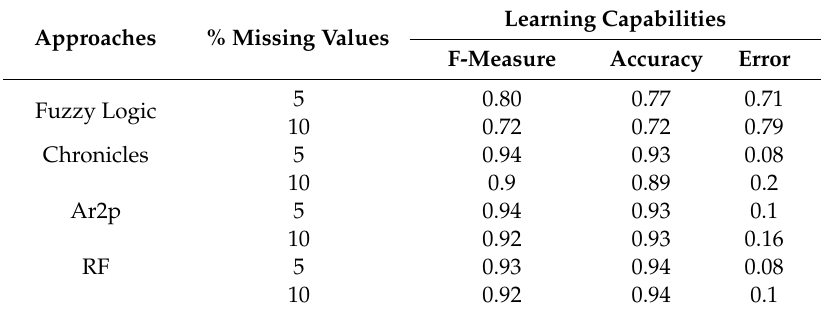
Table 15. Results of the Learning Capabilities with missing values during the testing